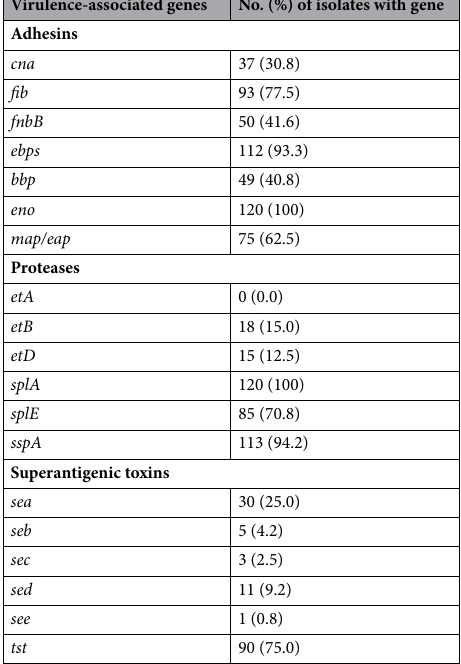
Table 1. The prevalence of virulence-associated genes in MRSA isolates from patients hospitalized in